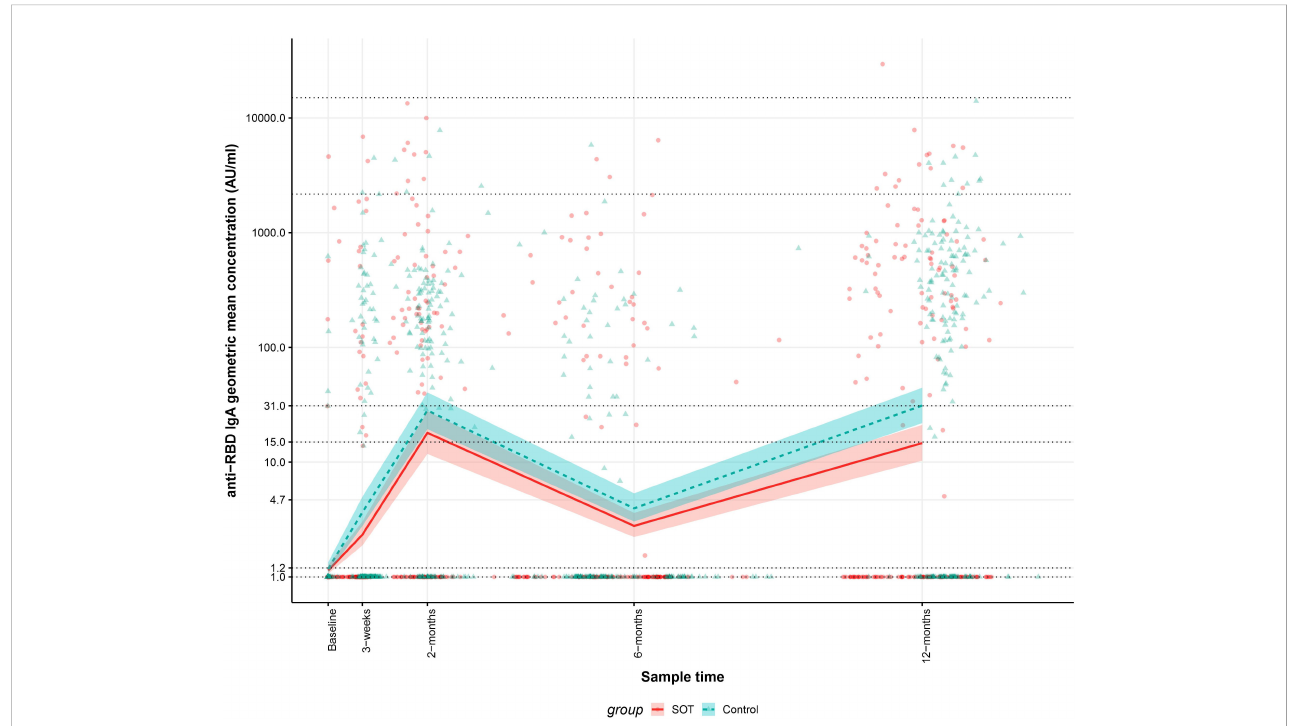
FIGURE 3 Kinetics of the modeled anti-receptor-binding domain (RBD) Immunoglobulin A (IgA) geometric mean concentrations (GMCs) in solid organ transplant (SOT) recipients and controls within 12 months after the fi rst BNT162b2 dose and observed anti-RBD IgG concentrations. The data include 204 SOT recipients (red) and 204 age and sex matched controls (blue). The modeled anti-RBD IgA GMCs in AU/mL with 95% con fi dence intervals are plotted on top of each indiviudal sample ’ s measured anti-RBD concentration in AU/mL. The y-axis is on a log10 scale. Dashed horizontal lines indicate modeled anti-RBD IgA GMC values for SOT recipients and controls at baseline and 12 months after fi rst BNT162b2 dose.